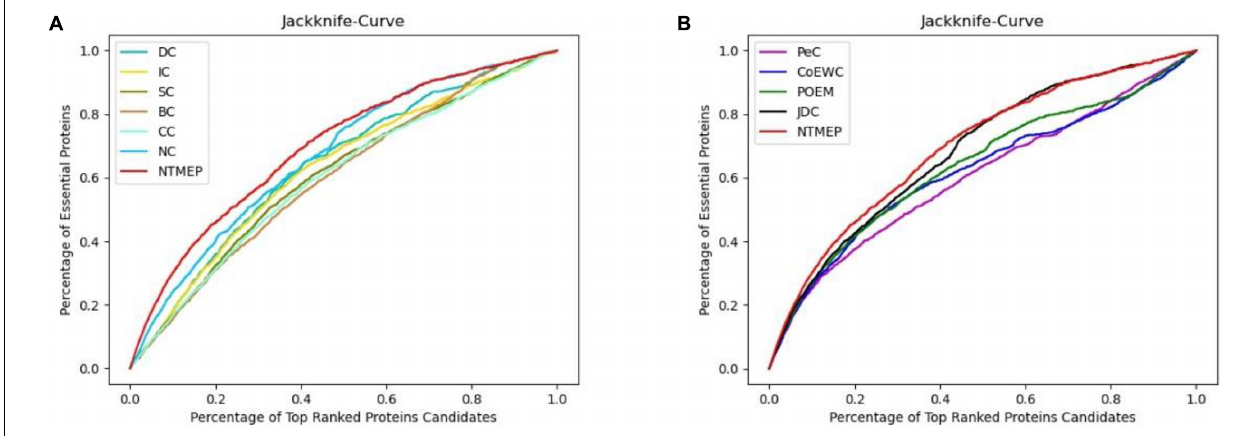
FIGURE 3 | Performance comparison between NTMEP and other ten methods in terms of Jackknife curves. (A) Jackknife curves of DC, IC, SC, BC, CC, NC, and NTMEP; (B) Jackknife curves of PeC, CoEWC, POEM, JDC, and NTMEP.